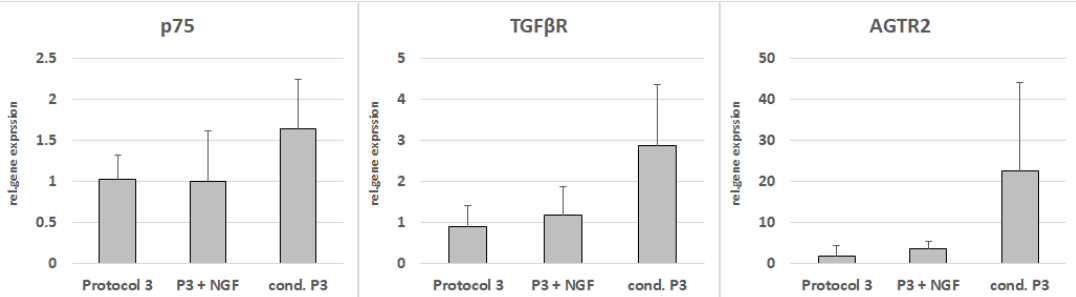
Figure 12. Gene expressions of p75, TGFR, and angiotensin II type 2 receptor (AGTR2) in NG-108-15 cells after indirect coculture with conditioned Protocol-3 medium, NGF-supplemented Protocol-3 medium, or unaltered Protocol-3 medium as control.